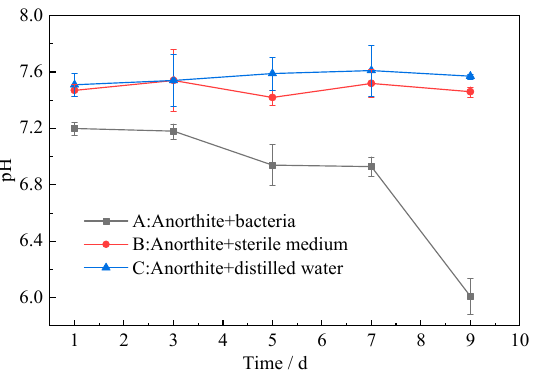
Figure 2. The pH values measurement results of the fermentation broth as a function of time.